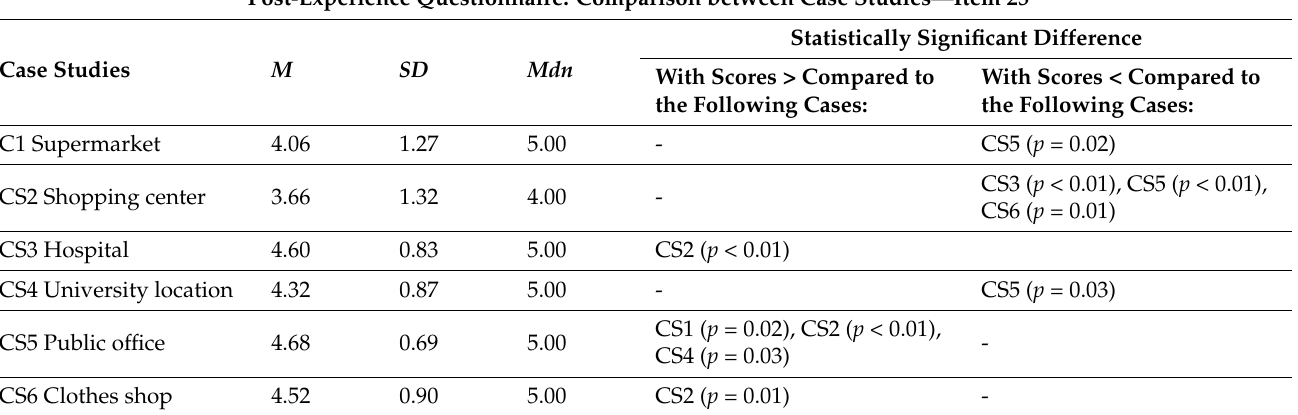
Table A27. Table shows the statistically significant differences ( p (BH)) that emerged from the comparison of item 25 in the different case studies (CS1–CS9). In the table is also reported the mean ( M ), the standard deviation ( SD ) and the median ( Mdn ). Own processing.